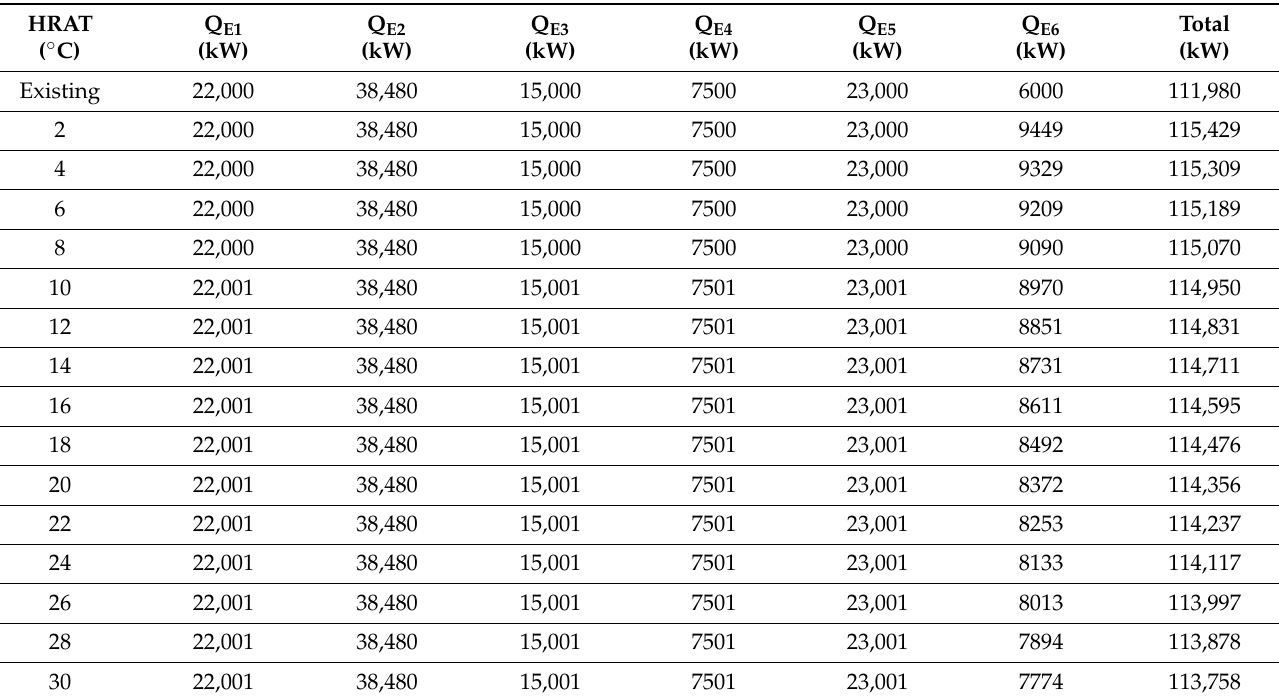
Table A4. Heat loads at different HRAT values for option (4).